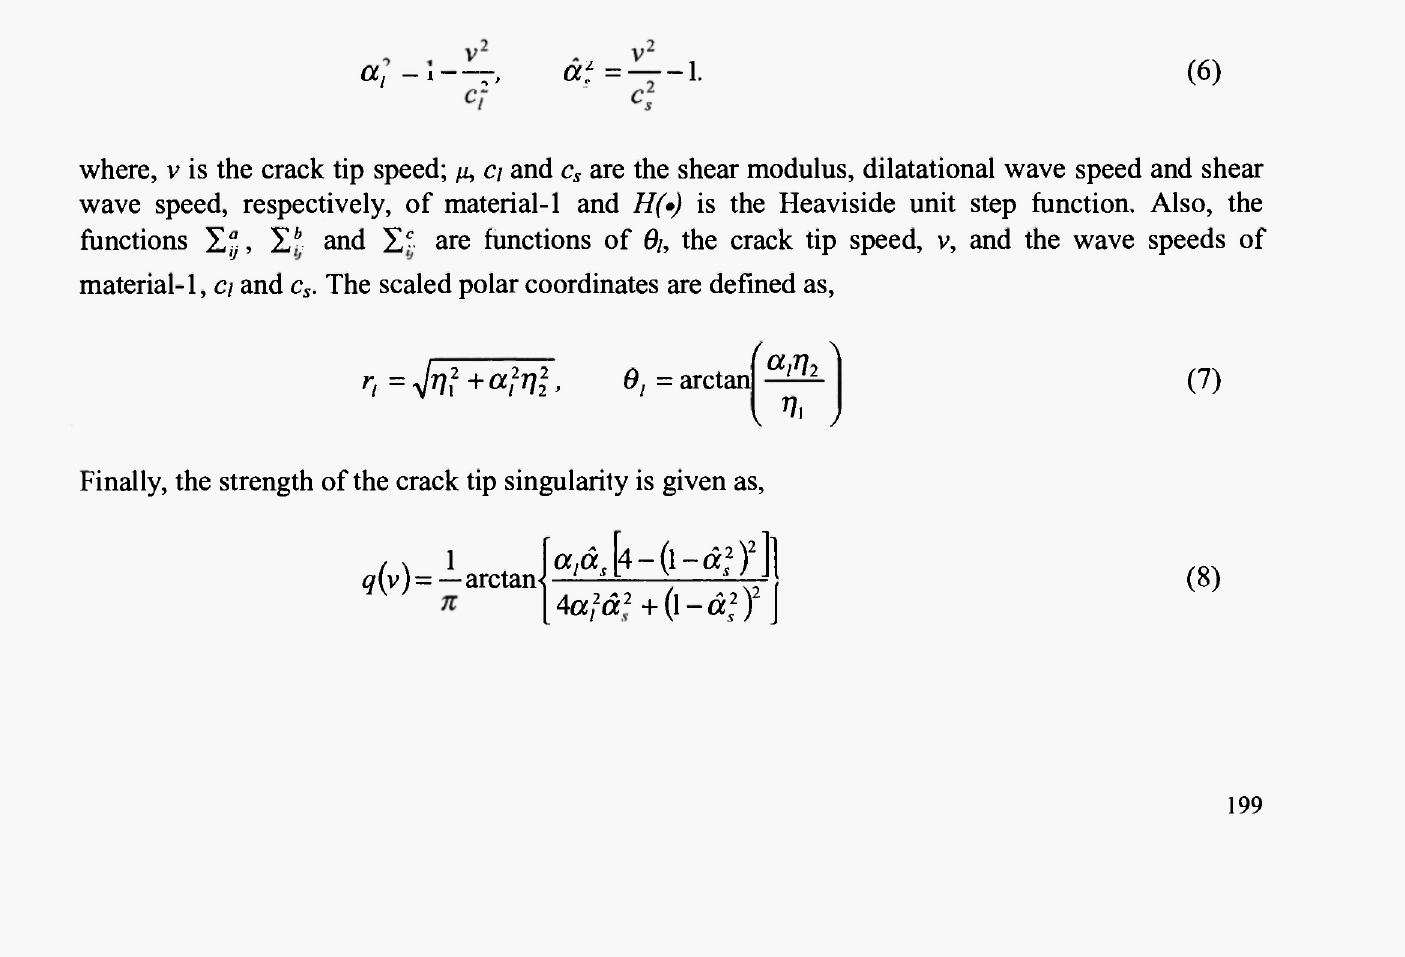
Figure 7: A crack propagating intersonically along an elastic/rigid